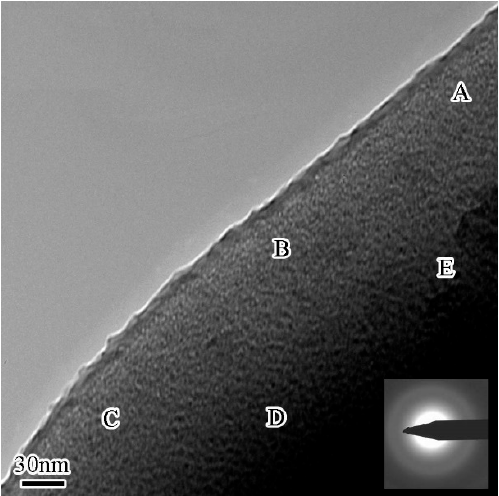
Figure 6. TEM morphology and the corresponding selected area diffraction pattern of the glassy phase. Table 1. TEM-EDS results of atom fraction of chemical composition of the glass phase in calcined K geopolymer .